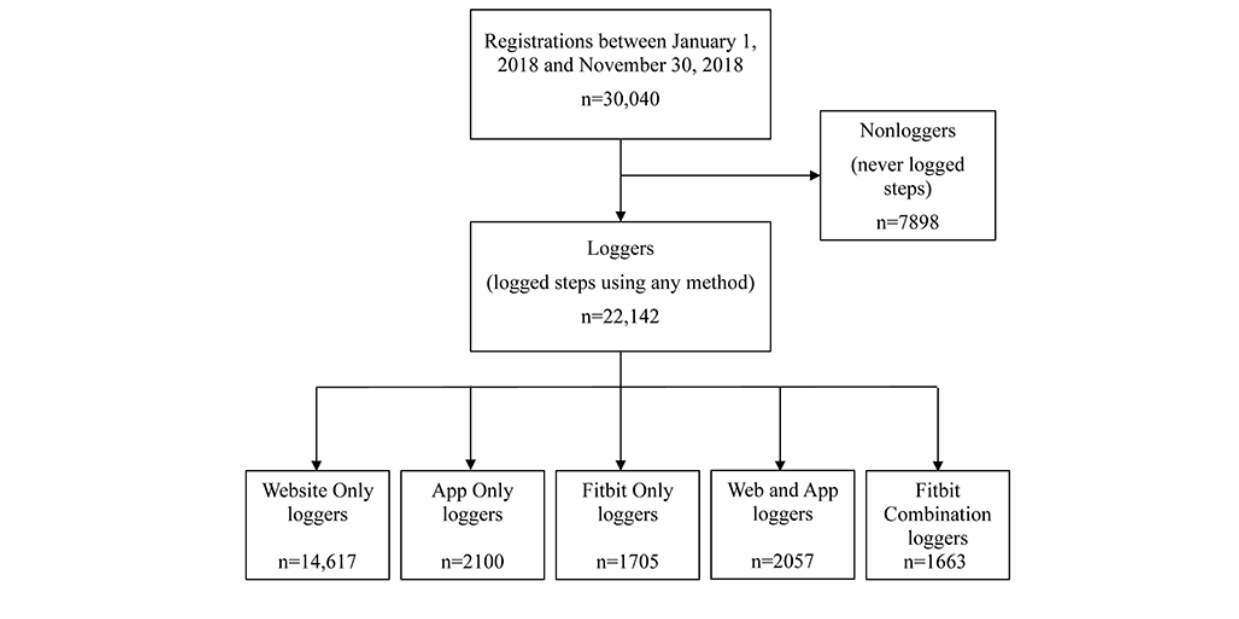
Figure 1. Classification of logging methods of new registrations to the 10,000 Steps program between January 1, 2018, and November 30,